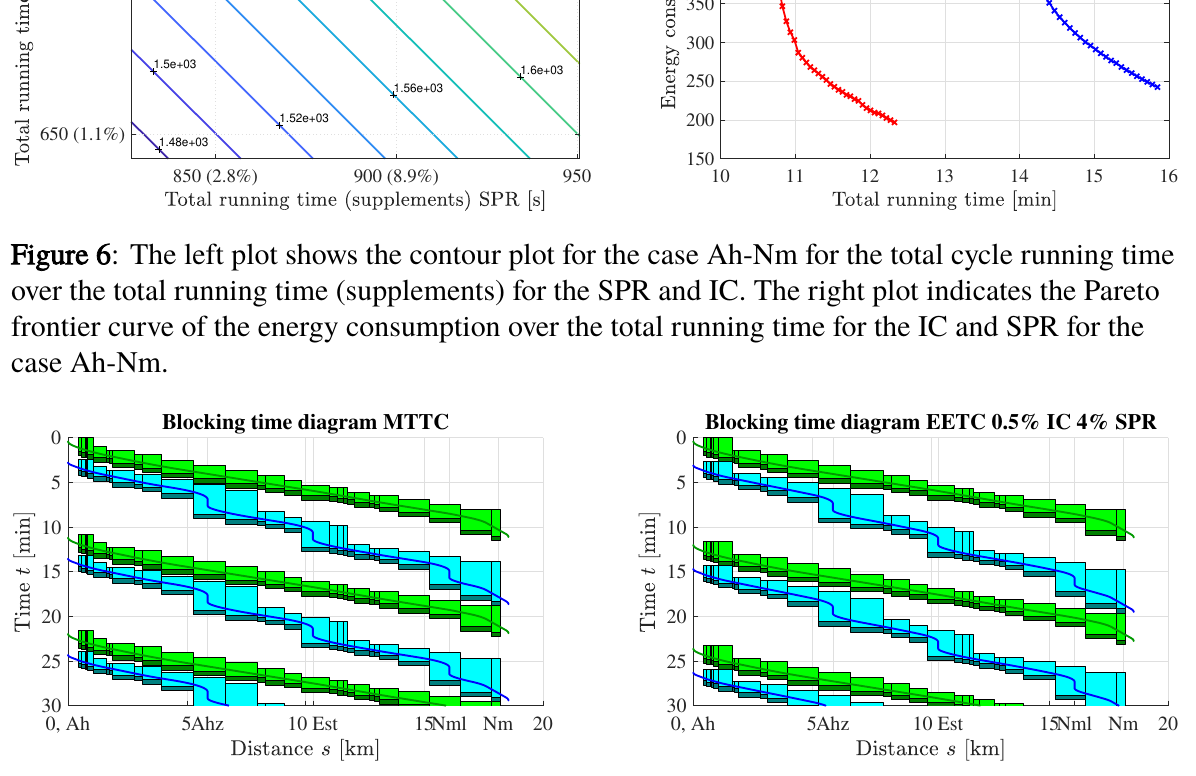
Figure 7: The left plot shows for the case Ah-Nm for the IC (green) and SPR (blue) compressed blocking time diagram of the MTTC driving strategies. The right plot indicates for the IC (green) and SPR (blue) compressed blocking time diagram EETC driving strategies for the case Ah-Nm. The EETC driving strategy has 0.5% running time supplements for the IC and 4% running time supplements for the SPR. The dark green and dark blue blocks are the minimum buffer time of 30